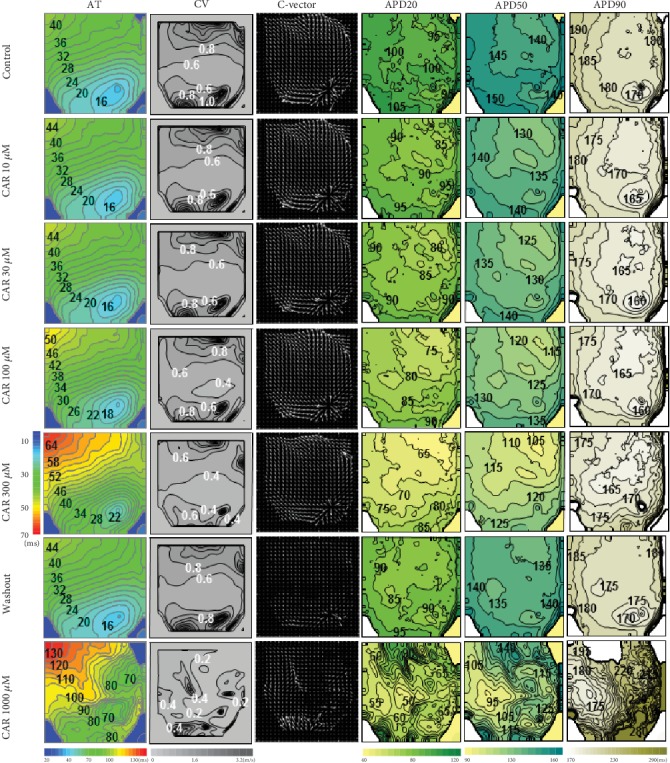
CAR effects on cardiac electrical activity of rabbit heart recorded by optical mapping using the fluorescent dye di-4-ANBDQBS. Representative optical maps of activation time (AT), conduction velocity (CV), conduction vector maps (C-vector), and OAPD maps (OAPD20, OAPD50, and OAPD90) obtained under control conditions and at 10, 30, 100, 300, and 1000 μM concentrations of CAR. Endocardial pacing was set at 300 ms. The number near the isochrones shows the activation times in AT maps (in ms). The conduction velocity is shown in CV maps (in m/s). AP duration maps are shown for OAPD20, OAPD50, and OAPD90 (in ms). The interval between isochrones is 2 ms for the AT and 0.2 m/s for the CV. The AT was calculated as the time interval from stimulus to 50% depolarization. OAPD20, OAPD50, and OAPD90 were calculated at 20%, 50%, and 90% of repolarization, respectively, from the AT. Note: 1000 μM CAR was applied after the washout period with Tyrode solution without the drug. The corresponding scale bars are given in the left and at the bottom.